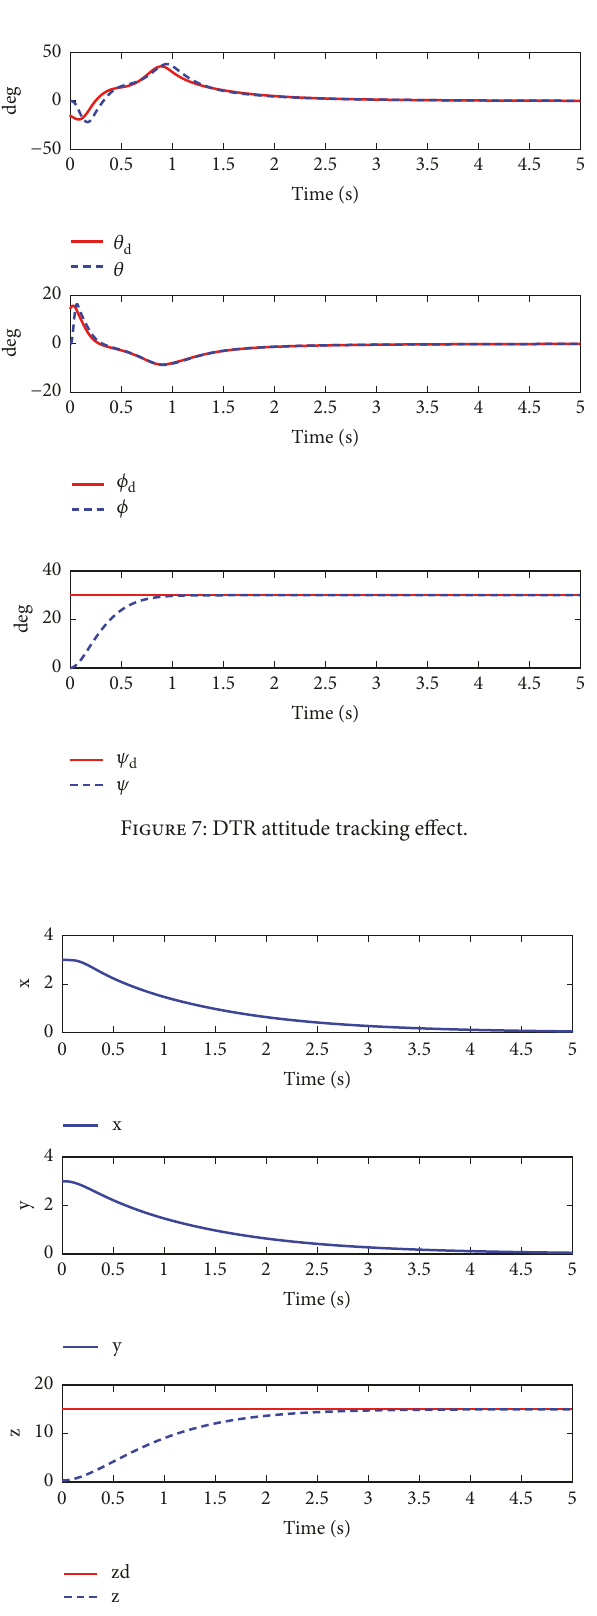
Figure 8: DTR position tracking